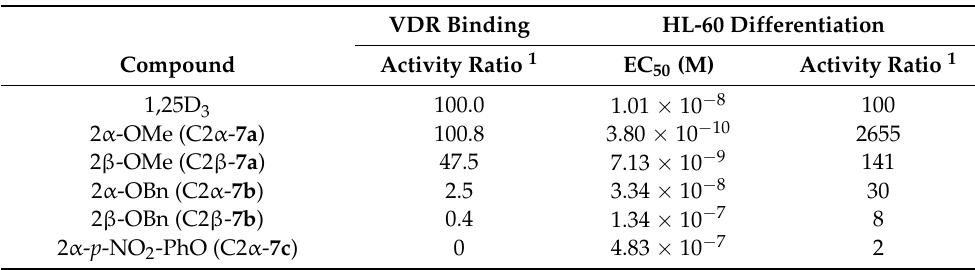
Table 2. Relative VDR binding affinity and the HL-60 cell differentiation-inducing activity of C2- alkoxy substituted 19-nor type D 3 derivatives, 7a – c .